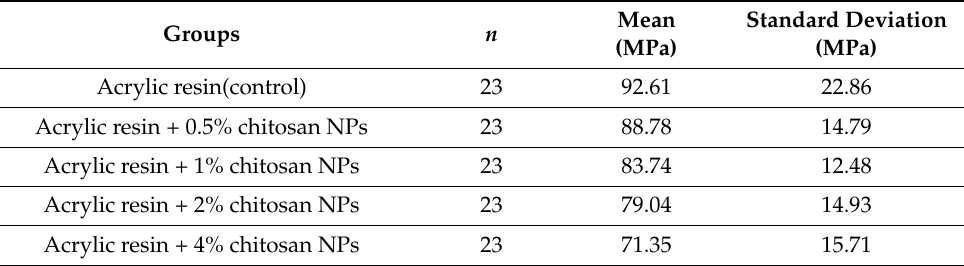
Table 3. Mean and standard deviation of the compressive strength in five different groups ( p <